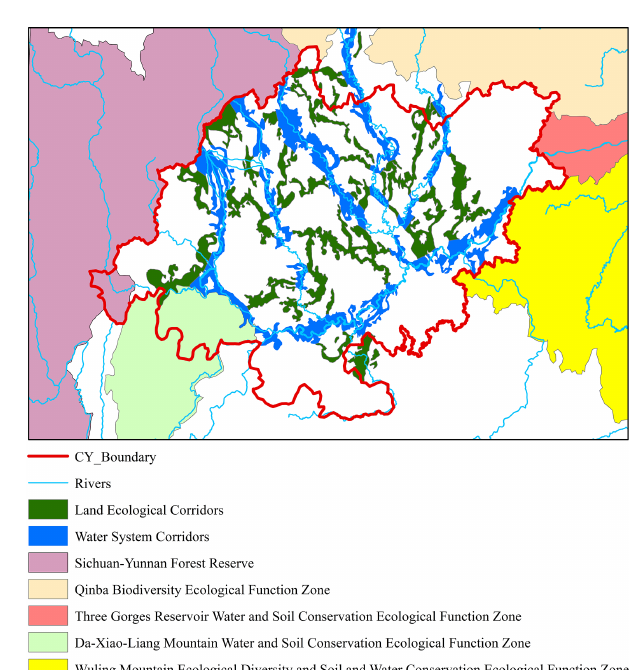
Figure 3. Scope of future land use scenarios planned through gov- ernment policy